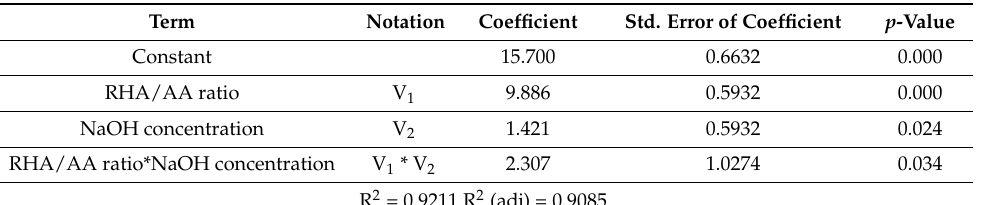
Table 7. Estimated effects and coefficient for RHA/AA ratio and NaOH concentration on the compressive